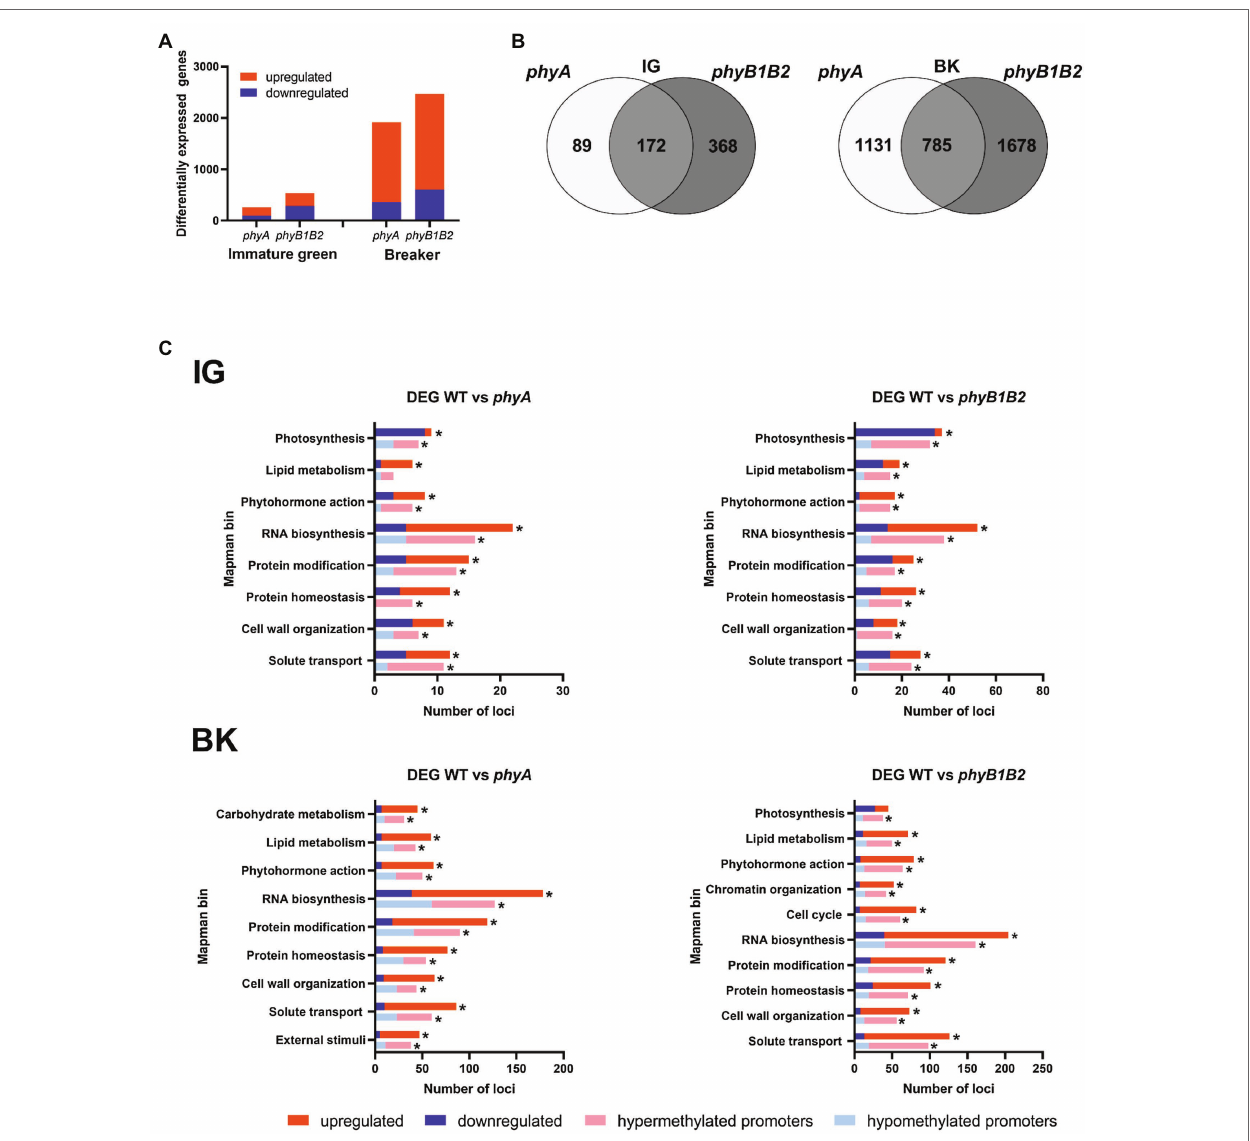
FIGURE 1 | PHYA and PHYB1B2 modify the global transcriptomic profile of tomato fruit. (A) Number of differentially expressed genes (DEGs) in phyA and phyB1B2 mutant fruits at immature green (IG) and breaker (BK) stages. (B) Venn diagram showing exclusive and common DEGs in phyA and phyB1B2 mutants in both developmental stages. (C) Functional categorization of all DEGs and those DEGs with differentially methylated promoters (DMPs) in both analyzed genotypes and stages. Only categories containing at least 2% of the DEGs or DMPs in each comparison are shown (asterisks). Up- and downregulated genes are indicated in red and blue, respectively. Loci with hyper- and hypomethylated promoters are indicated in light red and light blue, respectively. DEGs and DMPs show statistically significant differences (FDR < 0.05) relative to